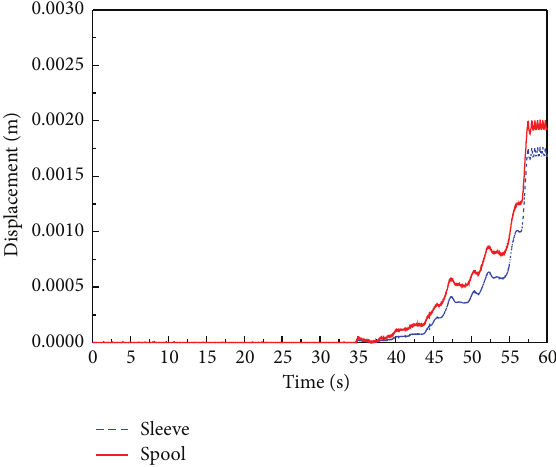
Figure 25: Simulation results of the displacement of the sleeve and spool of the regulator.